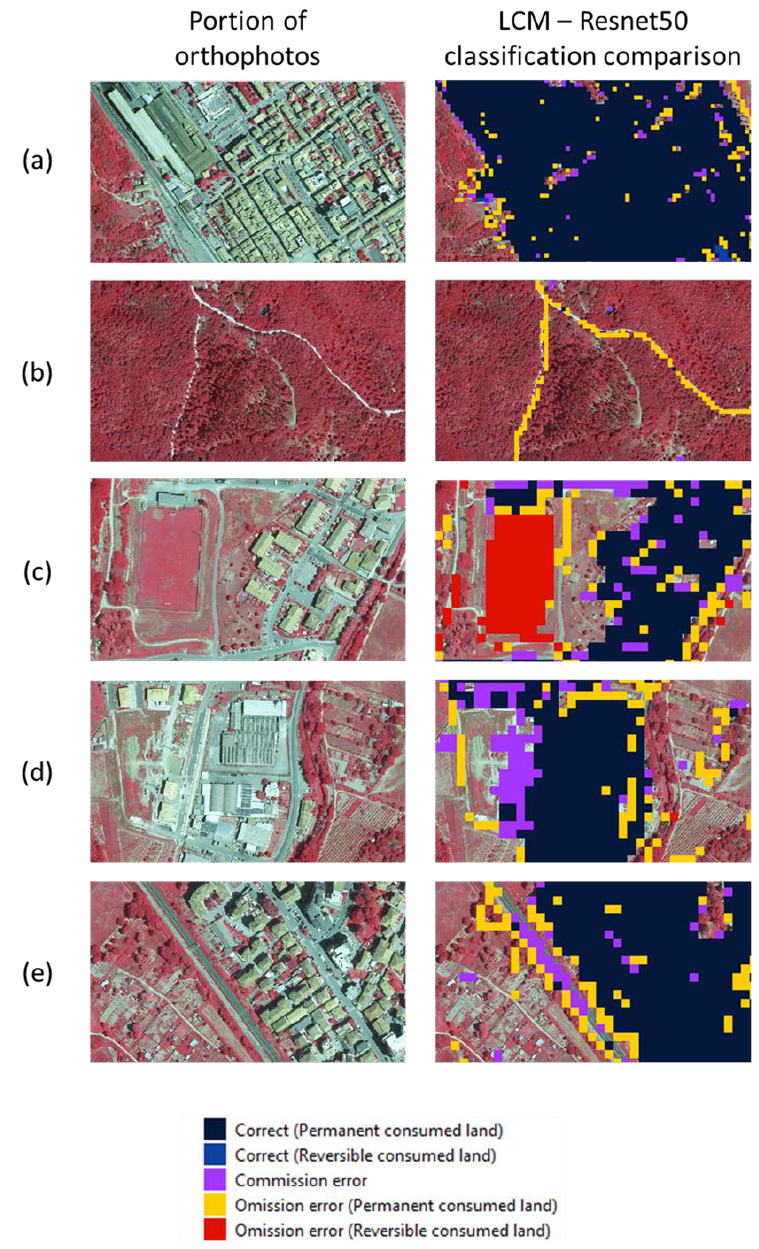
Figure 9. Comparison of the classification results with LCM: ( a ) Example of an excellent recognition of built-up areas; ( b ) omission error of a secondary road in a forest area; ( c ) omission error referred to as a sports field mapped by the LCM as reversible consumed land; ( d ) example of the DL algorithm correctly mapping an area that LCM does not identify as consumed land; and ( e ) errors related to the different resolutions of the two considered data.